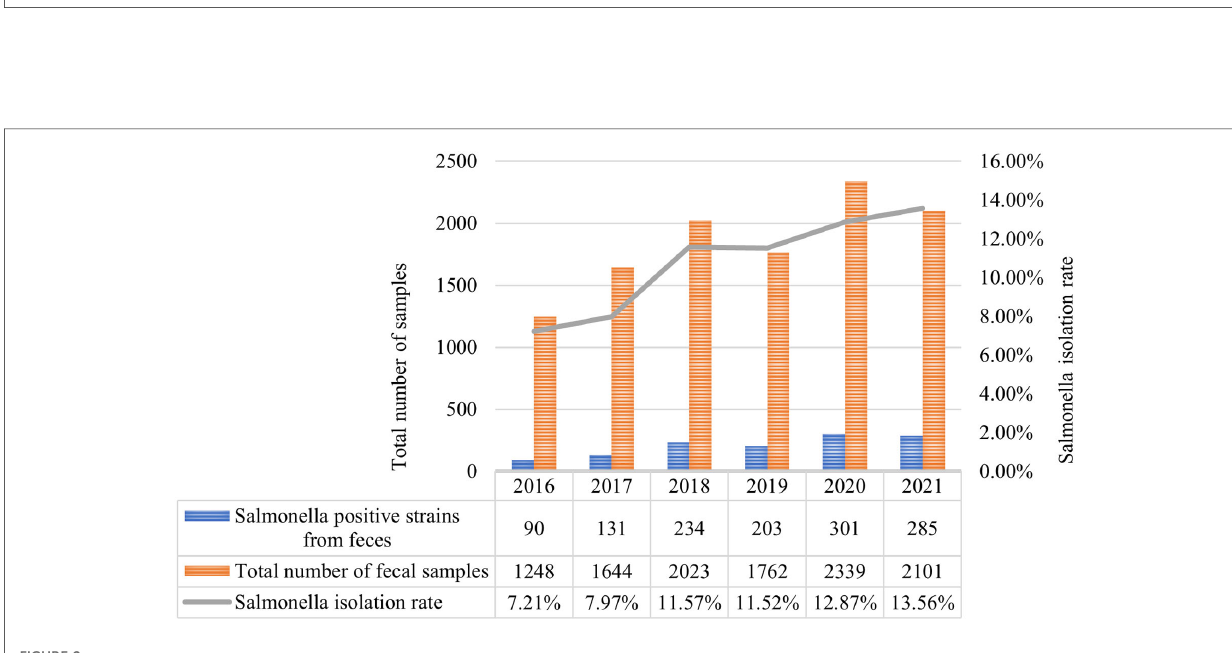
( Table 2 ). The isolate numbers of all serogroups increased dramatically over time. The isolate number in 2020 was 335 strains and 316 strains in 2021 ( Figure 1 ). As shown in Table 1 , the total isolation number was 93 in spring, 356 in summer, 608 in autumn, and 281 in winter. Among the isolated strains, 92.8% (1241/1338) of strains were collected from feces, 5.2% (71/1338) from blood, 1.0% (13/1338) from pus, and 1.0% (13/1338) from other kinds of samples ( Figure 2 ). As shown in Table 2 , 670 strains were isolated from inpatients and 668 strains from outpatients; 826 from male and 512 from female (ratio 1.6:1). Symptoms were mainly fever and diarrhea, with some patients experiencing vomiting, respiratory infection and leukemia